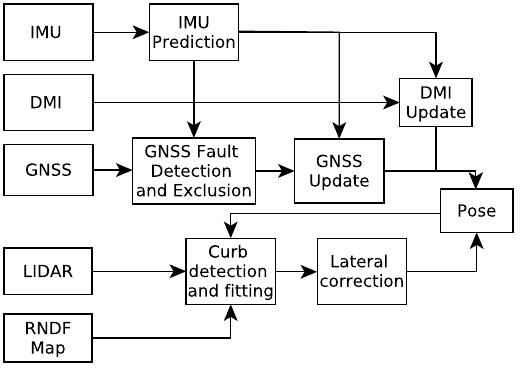
Figure 1. The flowchart of the proposed method. DMI, Distance-Measuring Instrument; RNDF, Route Network Definition